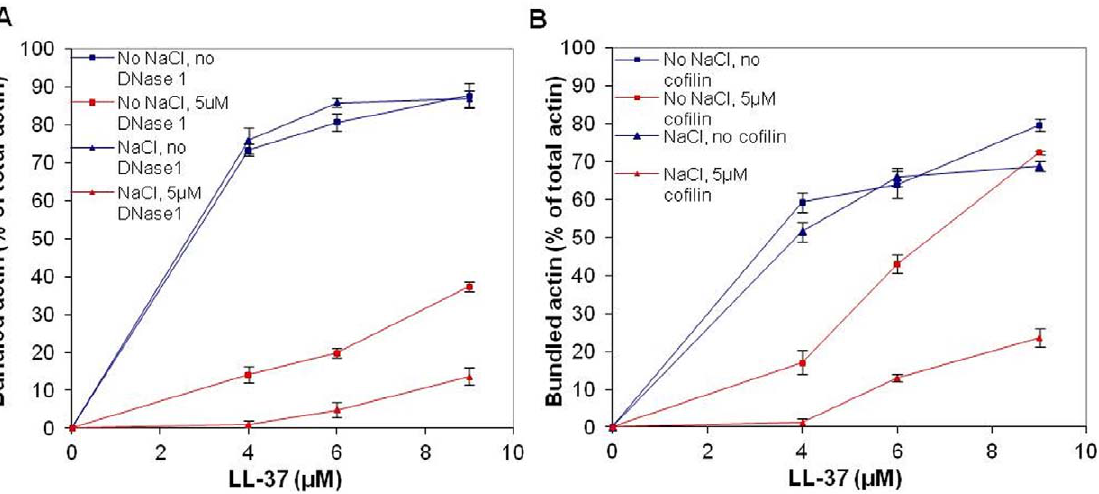
Figure 7. Dissociation of LL-37-induced Mg-F-actin bundles by DNase1 and cofilin at low and physiological ionic strength. 5 m M DNase1 or cofilin were added to 4 m M Mg-F-actin bundles (bundled by 4–9 m M LL-37) in the presence or absence of 100 mM NaCl. Following 30 min incubation the samples were centrifuged at 20,800 6 g for 8 min and the supernatants were analyzed by SDS-PAGE and densitometry. ( A ) Dissociation by DNase1. ( B ) Dissociation by cofilin. The presented data are mean and standard deviation of three independent